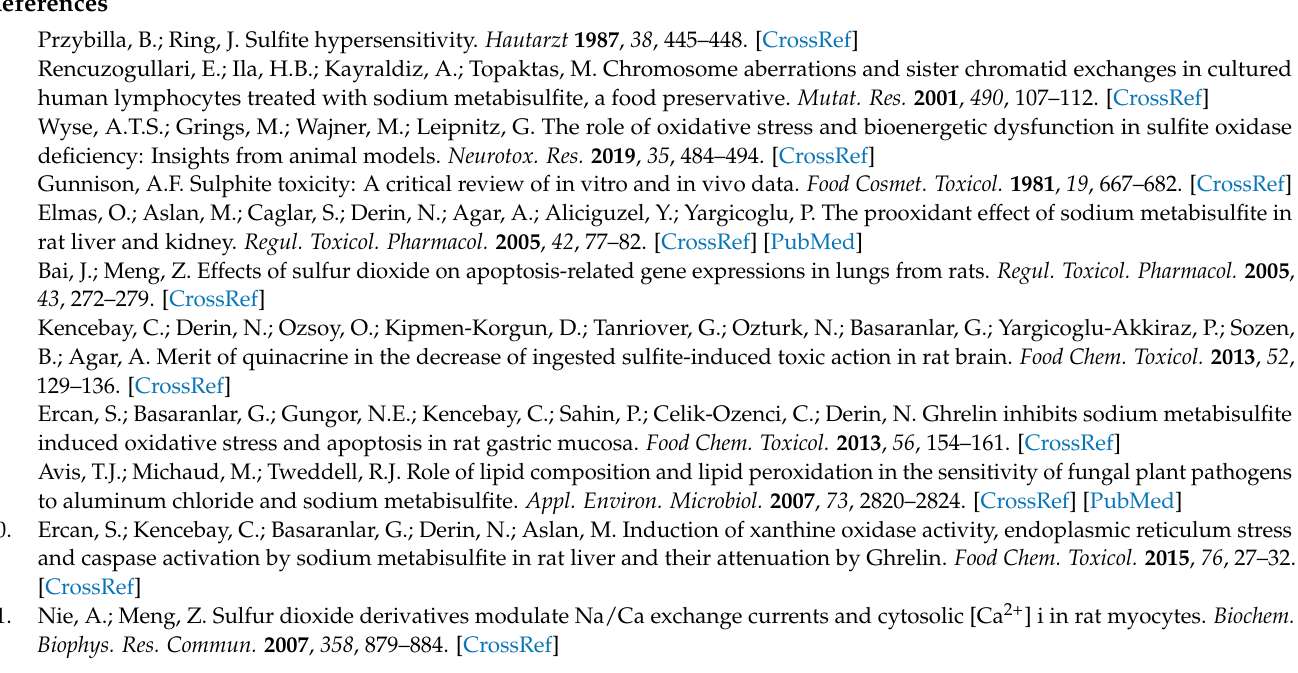
presence of Na 2 S 2 O 5 , Figure S2: Overlapping mutants identified both in our screen and in previous competition experiments, Figure S3: Functional analysis for the 16 genes deleted in Na 2 S 2 O 5 tolerant strains, Figure S4: Changes in protein expression and cell mortality rate are not determinants of retromer complex mislocalization, Table S1: The primers for the homologous recombination, Table S2: The 162 genes corresponding to Na 2 S 2 O 5 -sensitive mutants identified from the genome-wide screen, Table S3: The 16 genes corresponding to Na 2 S 2 O 5 -tolerant mutants identified from the genome-wide screen, Table S4: The information of all deletion mutants tested in the genome-wide screen, Table S5: The information of the deletion mutants in the correlation